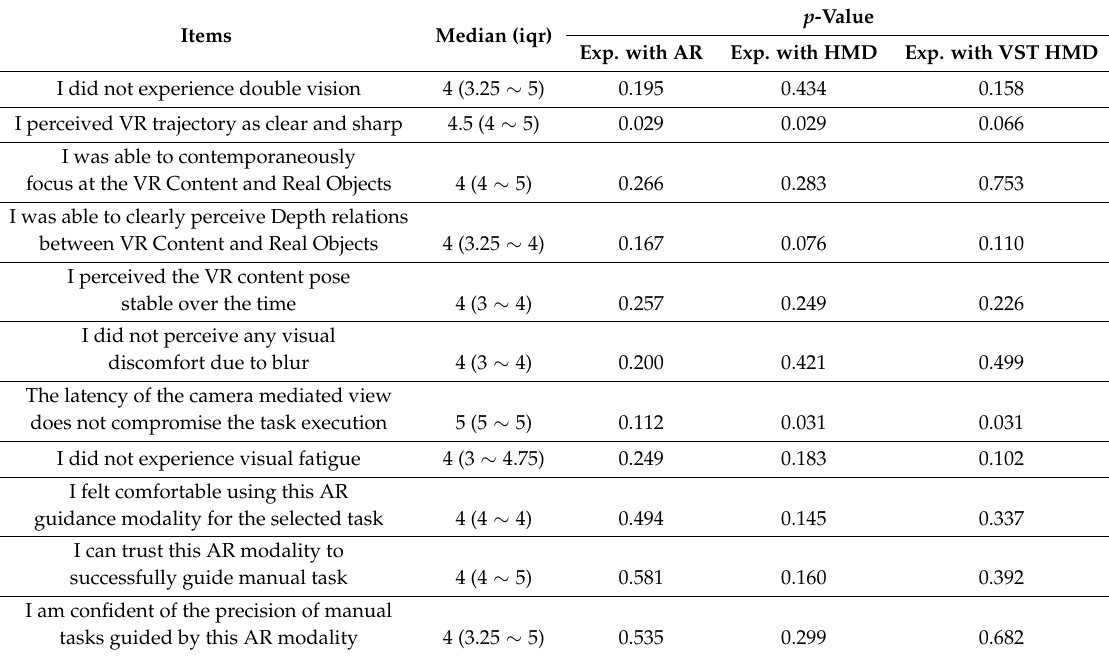
Table 2. Likert Questionnaire